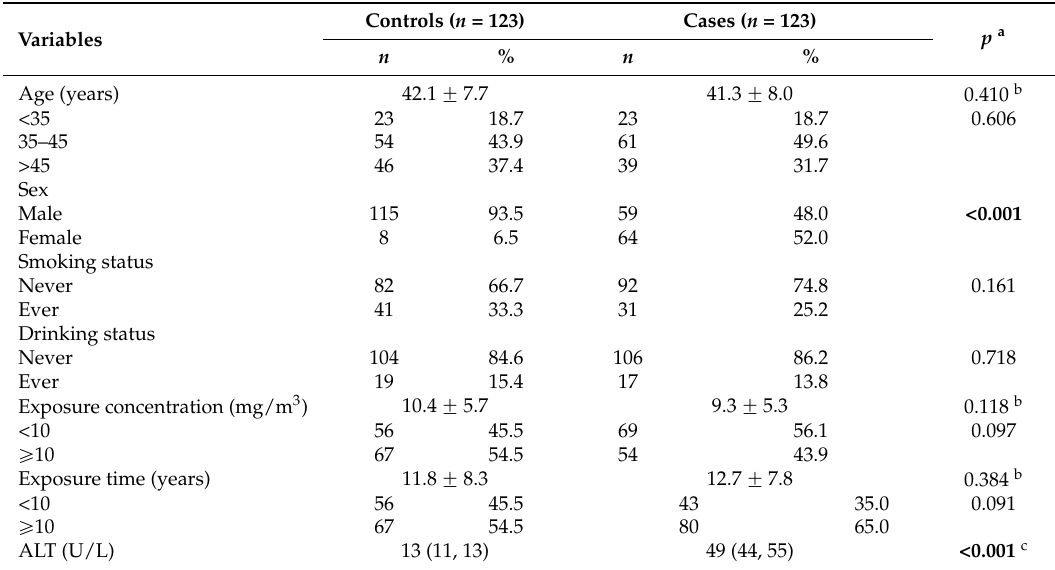
Table 1. Demographic and occupational characteristics of the cases and